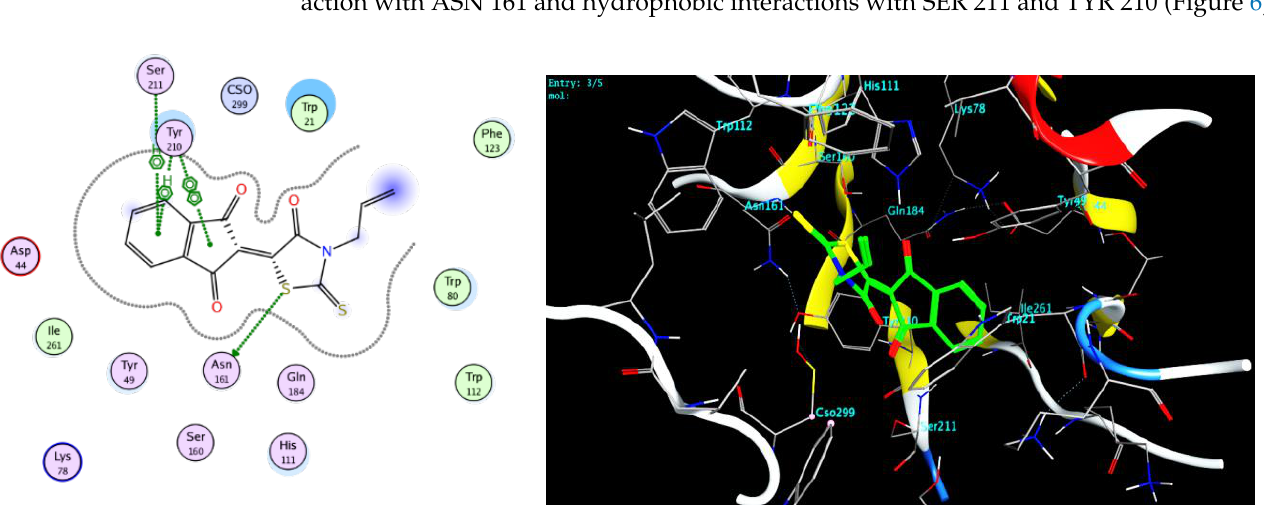
Figure 7. 2D and 3D docking of compound 5d with PPAR .